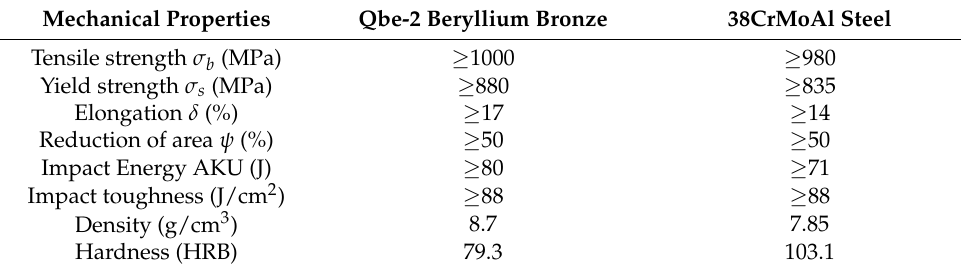
Table 3. Main mechanical properties of the friction materials.